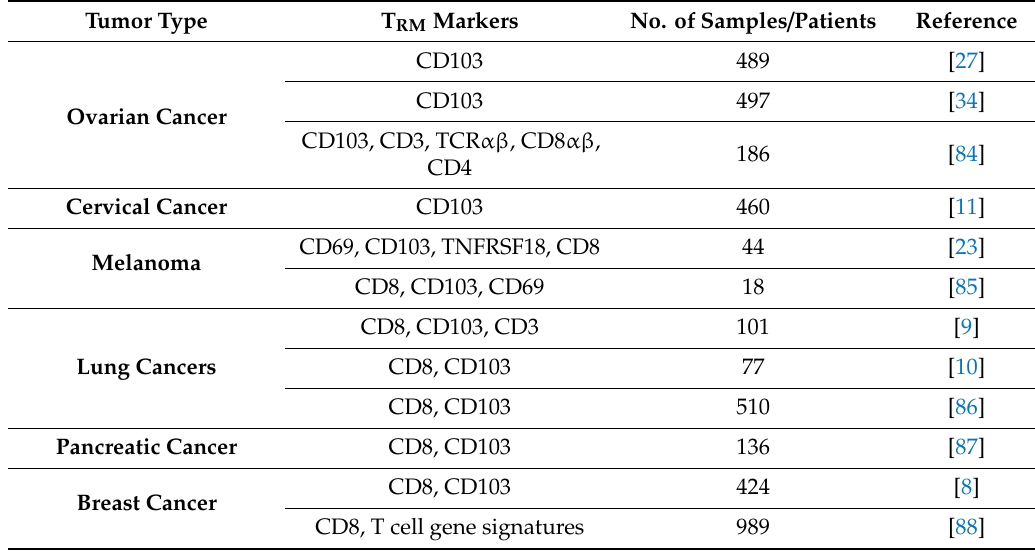
Table 1. Studies in solid tumors evaluating T RM cell populations reporting clinical